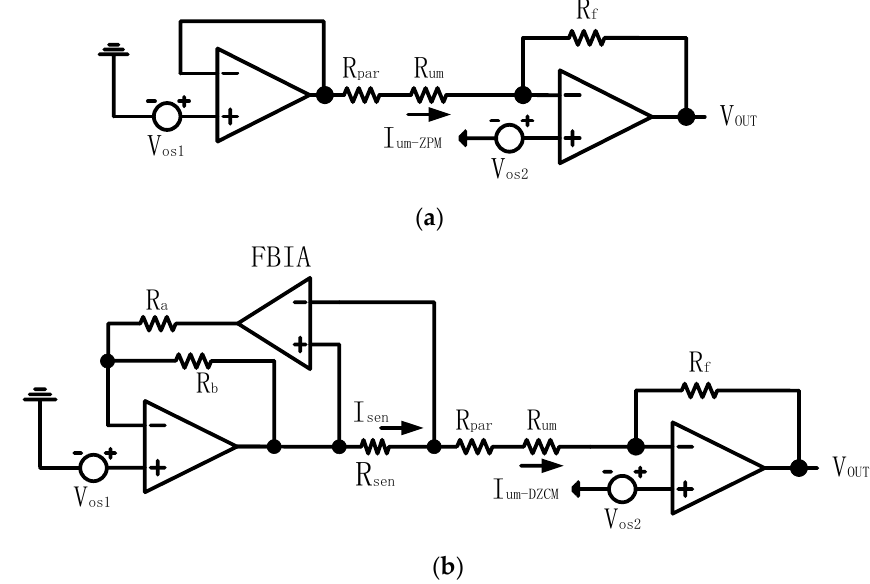
Figure 4. Simplification network with one unmeasured resistor of ( a ) ZPM and ( b ) DZCM.